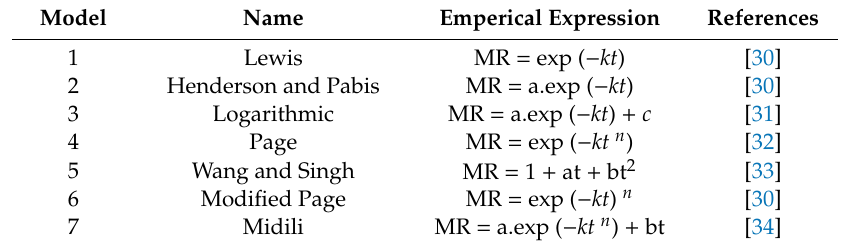
Table 1. Empirical models describing blanched and unblanched pomegranate aril drying kinetics.